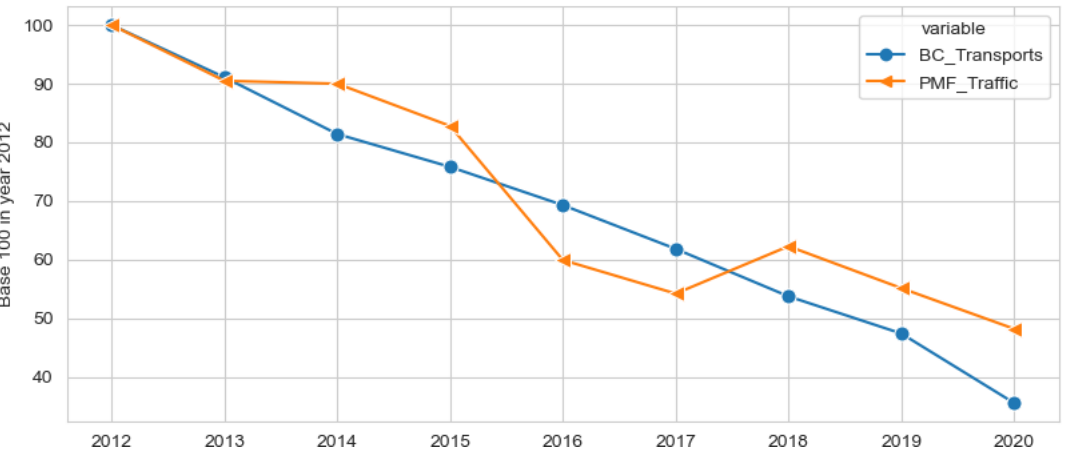
Figure 7. Comparison of the evolution of the traffic factor source contribution (in µgm − 3 ) at the OPE site and the black carbon (BC) emissions (in kilotonnes) by the transport sector (source: CITEPA, https://www.citepa.org/fr/2021-bc/) for overall